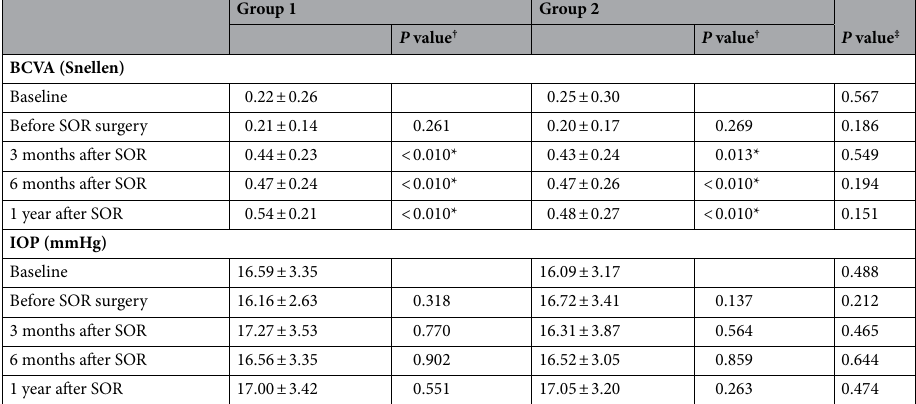
Table 2. Visual acuity and intraocular pressure measurements according to timing of ILM peeling. The data are shown as the mean ± standard deviation. Group 1, ILM peeling during SO injection surgery; Group 2, ILM peeling during SO removal surgery. † At each time point vs. baseline, paired t -test. ‡ Group 1 vs Group 2, independent t -test. * P < 0.05, statistically significant. BCVA best-corrected visual acuity, ILM internal limiting membrane, IOP intraocular pressure, SOR silicone oil